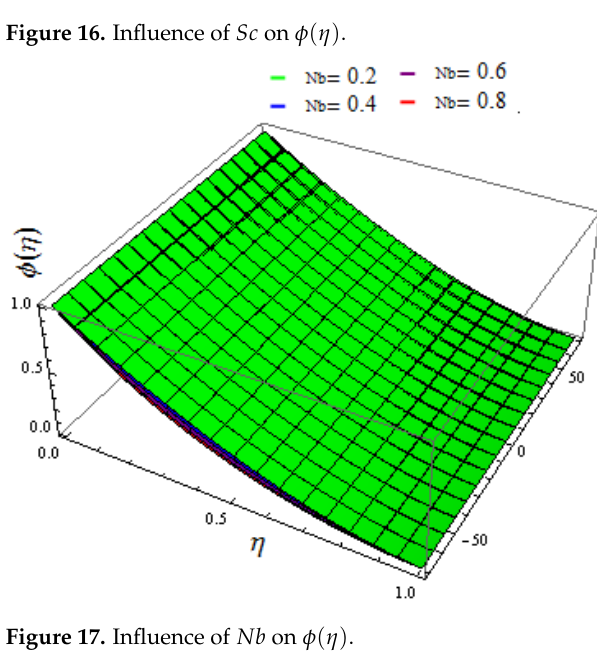
Figure 16. Influence of 𝑆𝑐 on 𝜙(𝜂) .